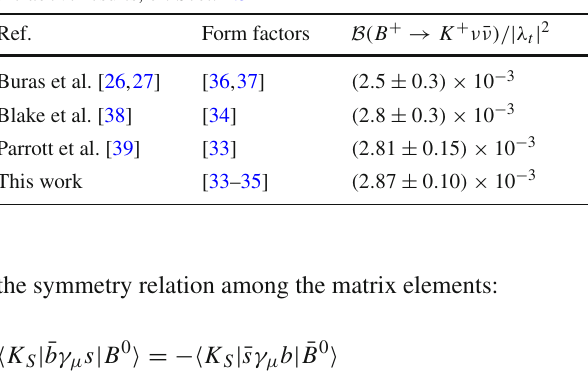
has not been included in F